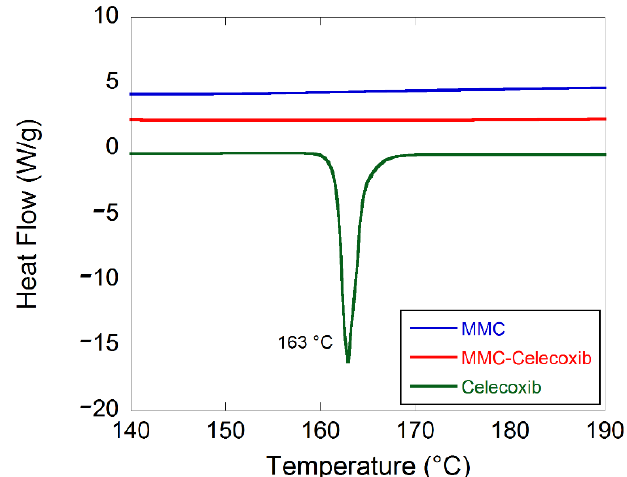
Figure 2. DSC thermograms for the three studied